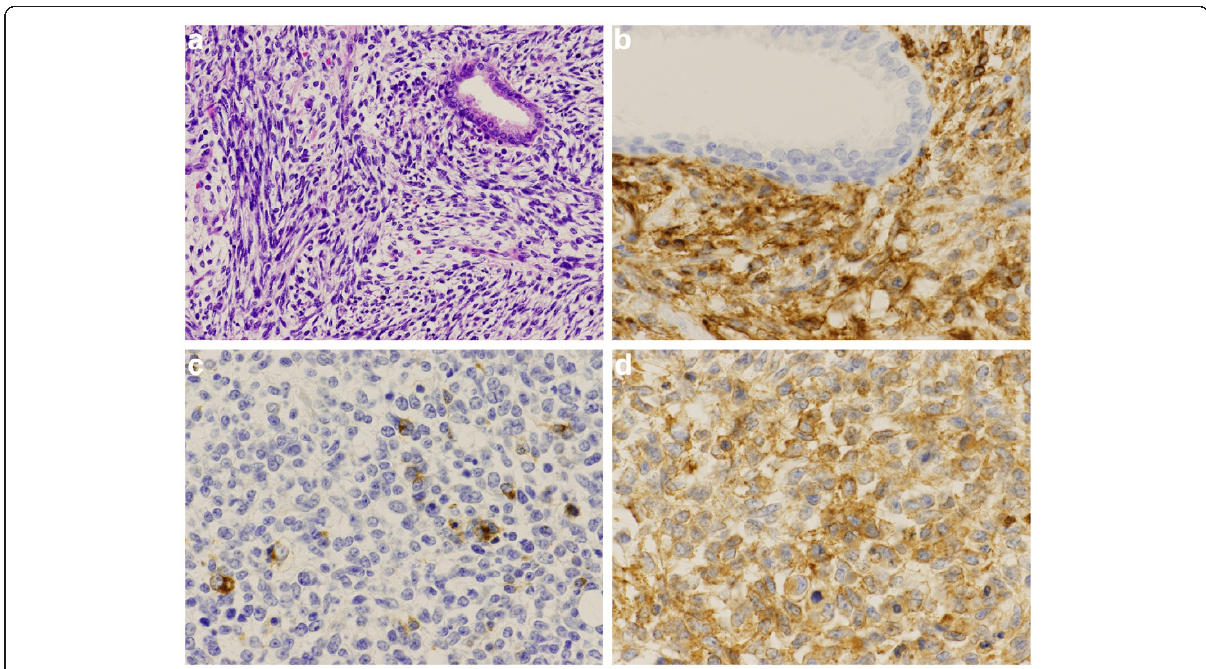
Figure 3 Microscopic findings. a )The tumor was made up of sarcomatoid oval to spindle cells. (HE x 100) b ) Immunostaining with CD56 showed positive results for tumor cells on the cell membrane (CD56 x 200). c ) Immunostaining with synaptophysin focally showed positive results for the tumor cells in the cytoplasm (synaptophysin x 200). d ) Immunostaining with CD99 showed positive results for tumor cells on the cell membrane (CD99 x